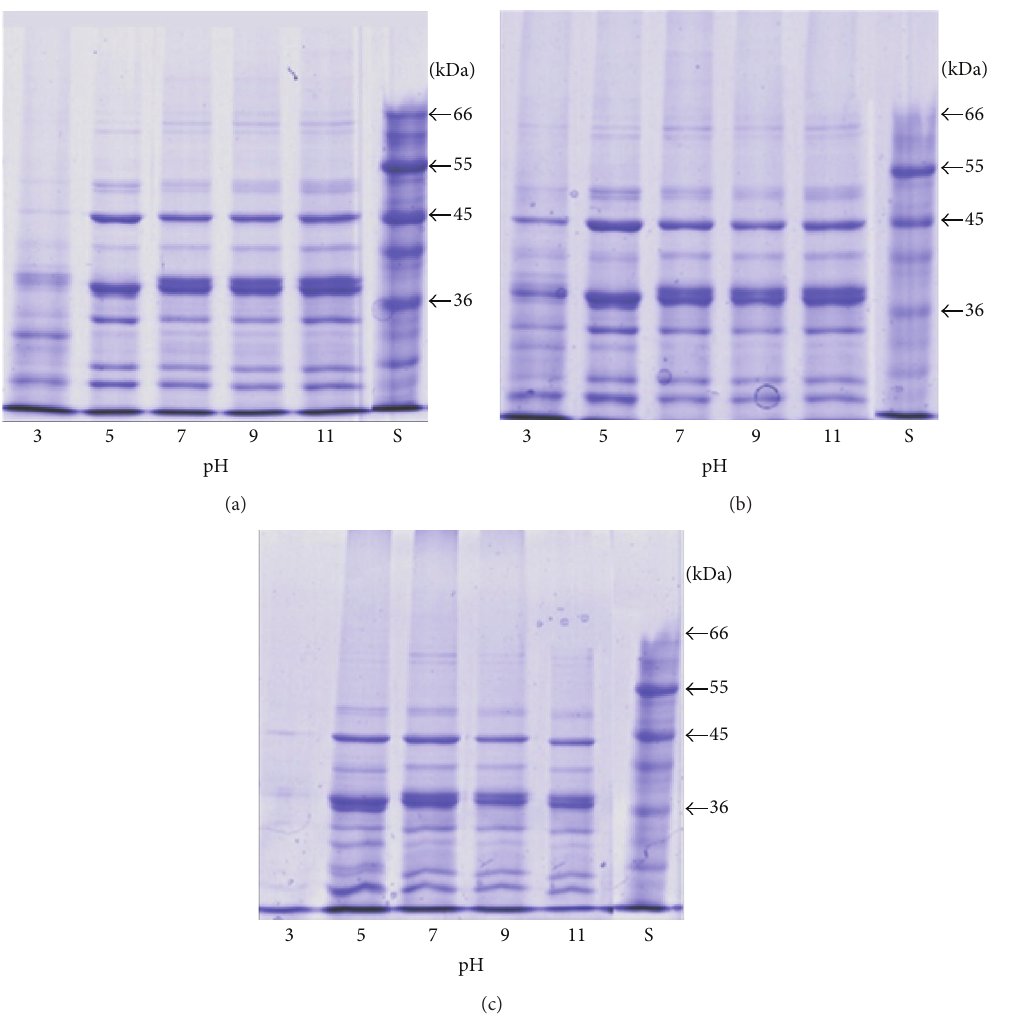
Figure 2: Protein patterns of SP from jumbo squid in (a) 0M NaCl, (b) 0.2 M NaCl, and (c) 0.5 M NaCl. The numbers indicate pH while S denotes molecular weight